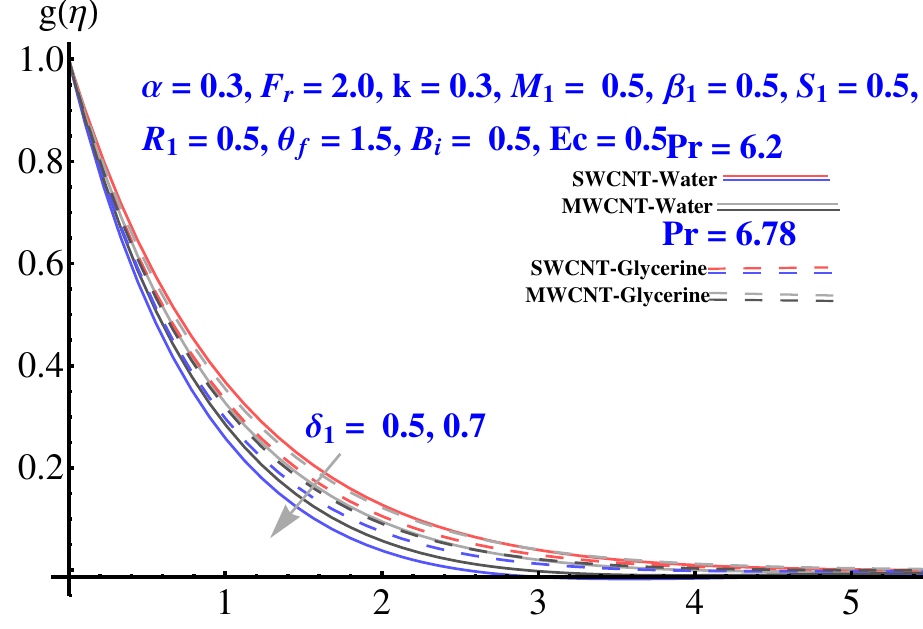
Figure 8. Impact of δ 1 on tangential